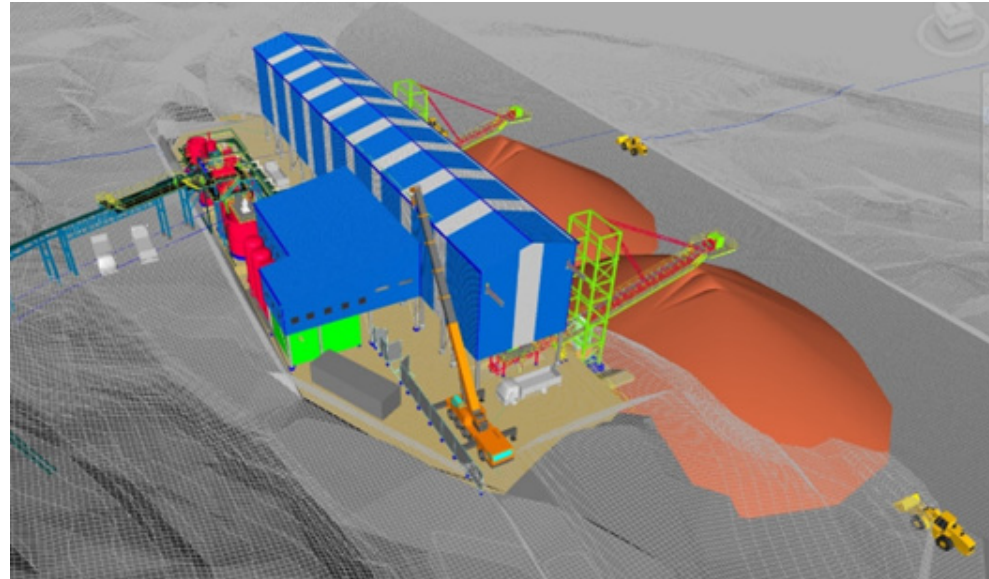
Figure 75. Chungar Tailings Filtering Plant.